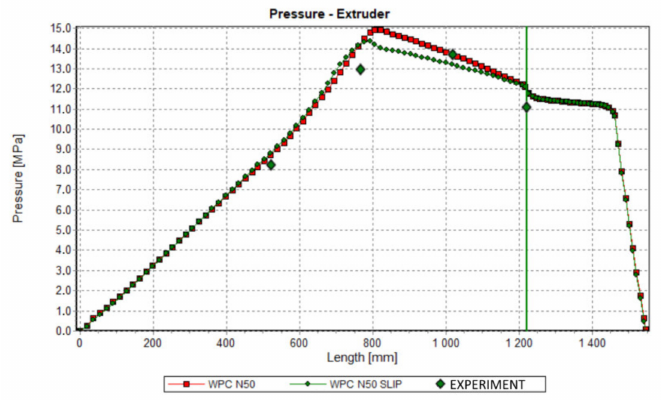
Figure 16. Validation of simulation: Pressure profile, N = 50 rpm.